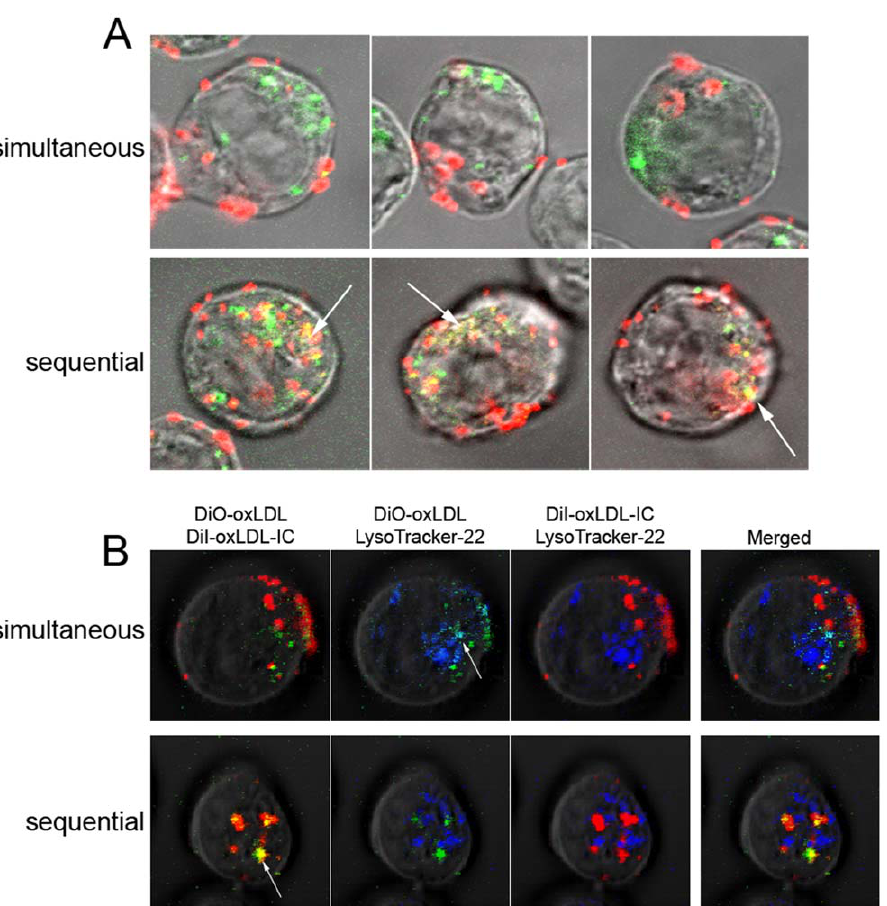
Figure 4. Lipid moieties of oxLDL and oxLDL-IC co-localize when administered sequentially but not simultaneously. U937 cells were incubated with DiI-oxLDL-IC (red) and DiO-oxLDL (green) ( A ) sequentially and ( B ) in parallel in U937 cells. They were incubated for a total of 5 h. Sequential experiment involved 2 h incubation of oxLDL-IC (32 m g/ml), prior to addition of oxLDL (24 m g/ml) for 3 h. Lyso Tacker Blue DND-22, (50 nM) was used and applied for the last 30 min of incubation. Cells were fixed with 4% formaldehyde, suspended in sealed capillaries and visualized using Zeiss LSM 510 Laser scanning confocal microscope. Arrows point at co-localization of oxLDL in the lysosomal compartment in the upper panel, and the co-localization of oxLDL and oxLDL-IC in the lower panel.